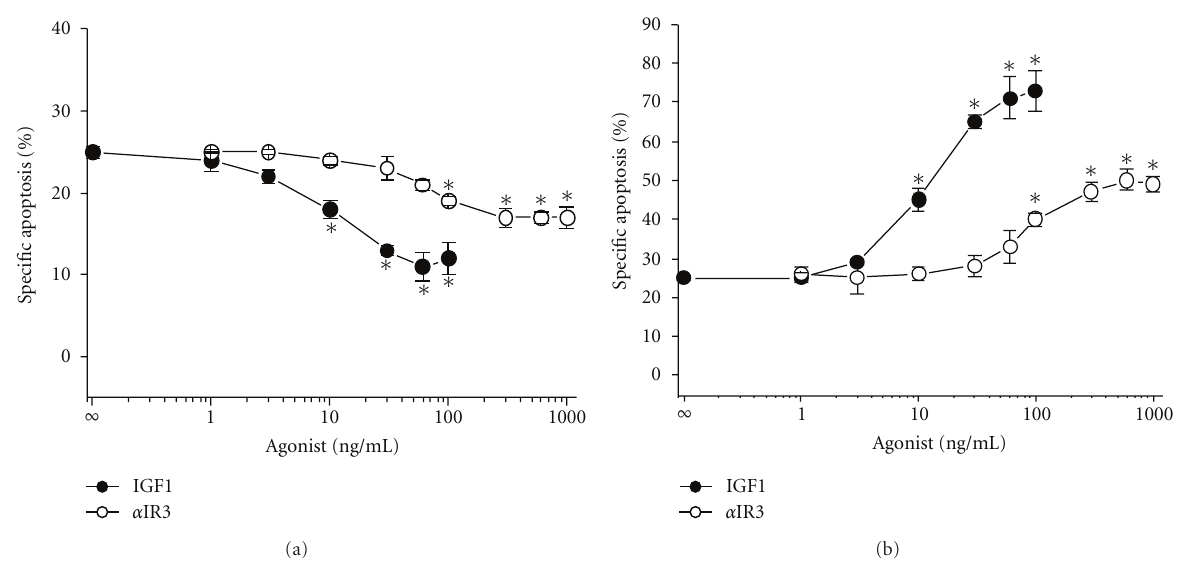
Figure 2: Concentration dependency of IGF1 and α -IR3 on Apo2L/TRAIL-induced apoptosis. Percentage-specific apoptosis in VH-64 cells treated for (a) 24 hours and (b) 72 hours with the indicated concentrations of IGF1 and α -IR3, followed by incubation with Apo2L/TRAIL (50ng/mL; 8 hours). All incubations contained nonspecific isotype IgG at a final concentration of 3 μ g/mL. Asterisks: ∗ P < 0 . 05; error bars: mean ± SD of triplicate determinations from 3 independent